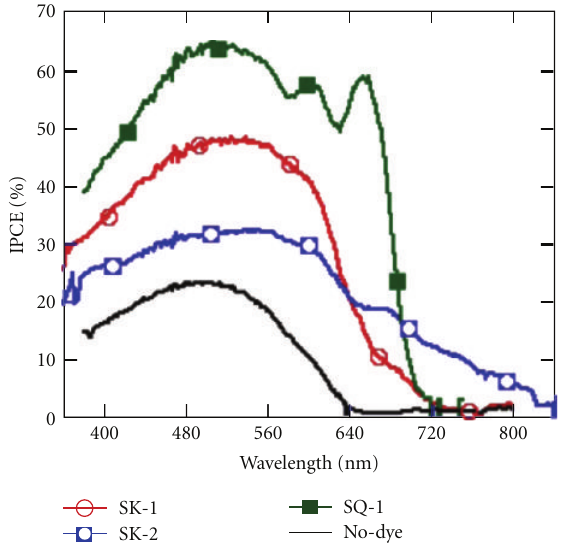
Figure 12: J - V curves showing the improved performance of a FTO/35nm pore, 600–700 nm length TiO 2 nanotube array/SQ- 1 dye/P3HT/PEDOT:PSS/Au hybrid solar cell where the dye- sensitized nanotube array surface, prior to application of the P3HT layer, is wetted with 0.05 to 0.1 M tert-butyl pyridine in p-xylene. Also shown is the performance of an otherwise identical cell lacking the SQ-1 dye layer. L denotes cell performance under light illumination D denotes cell performance in the dark. Reprinted with permission from [7].